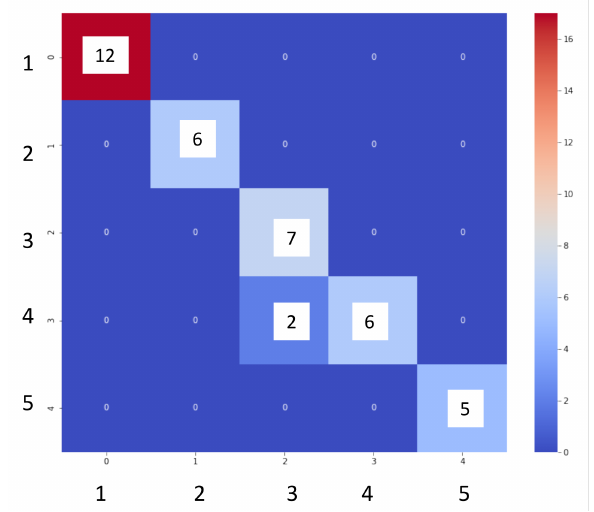
Figure 5. Confusion matrix for the decision tree method—flow data.